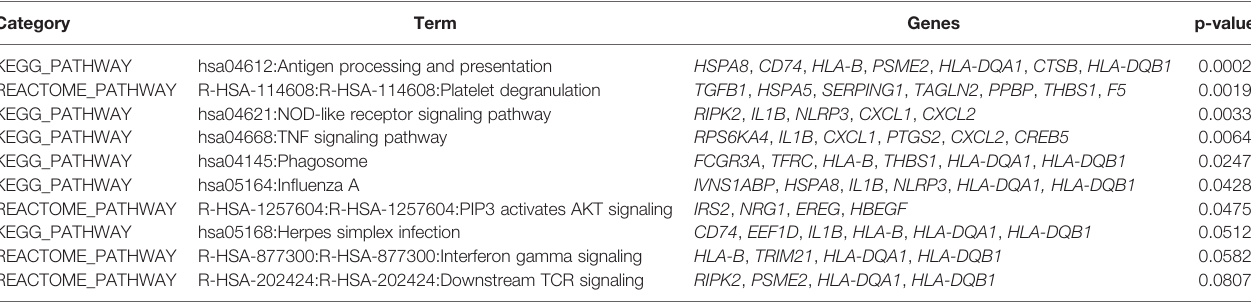
TABLE 4 | Pathways enriched for DEGs identi fi ed between CoV2+ and CoV2- groups (nominal p-value < 0.05).